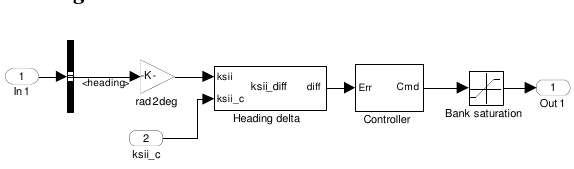
Fig 9. Zoom-in illustration of angle of attack Heading control